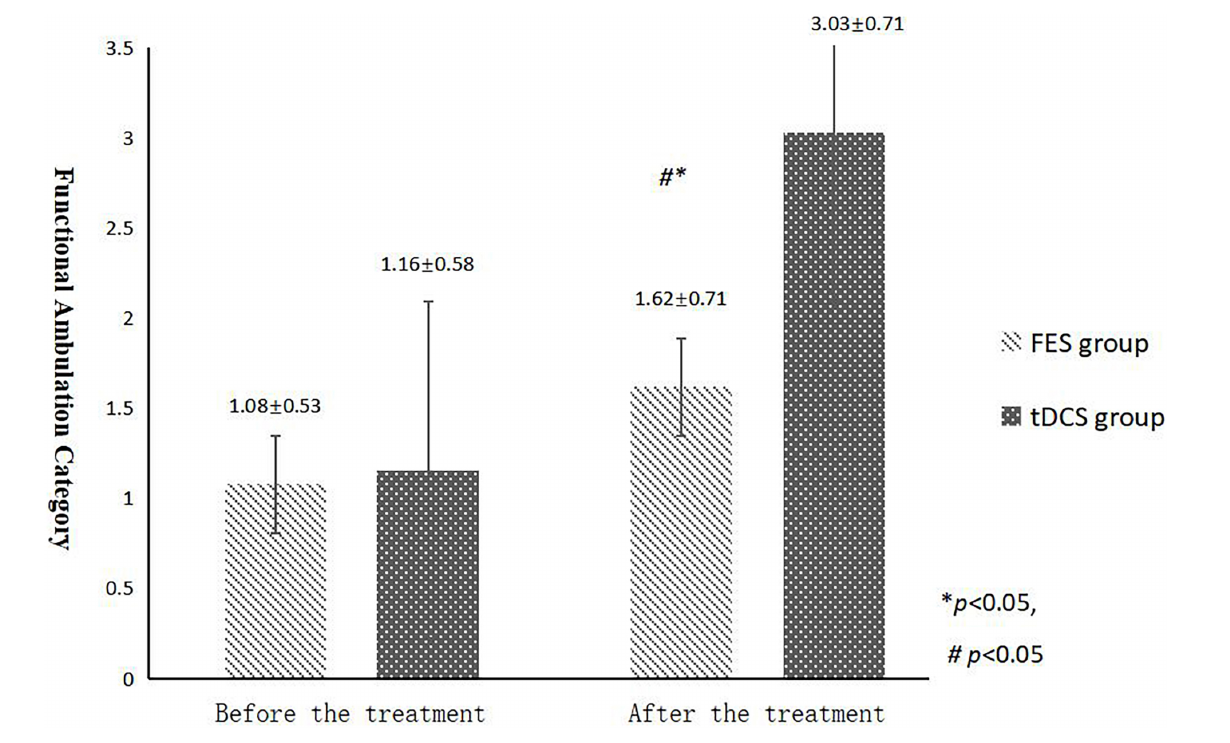
FIGURE 3 | FAC scores comparing improvement before and after FES and tDCS treatments in post-convalescent stroke patients. ∗ Indicates that the mean value of the tDCS and FES groups is significantly different at the same time point, p < 0.05. ∗∗ Indicates that the mean value of the tDCS and FES groups is significantly different at the same time point, p < 0.01. # Indicates that the mean score after treatment is significantly different from that before treatment, p <